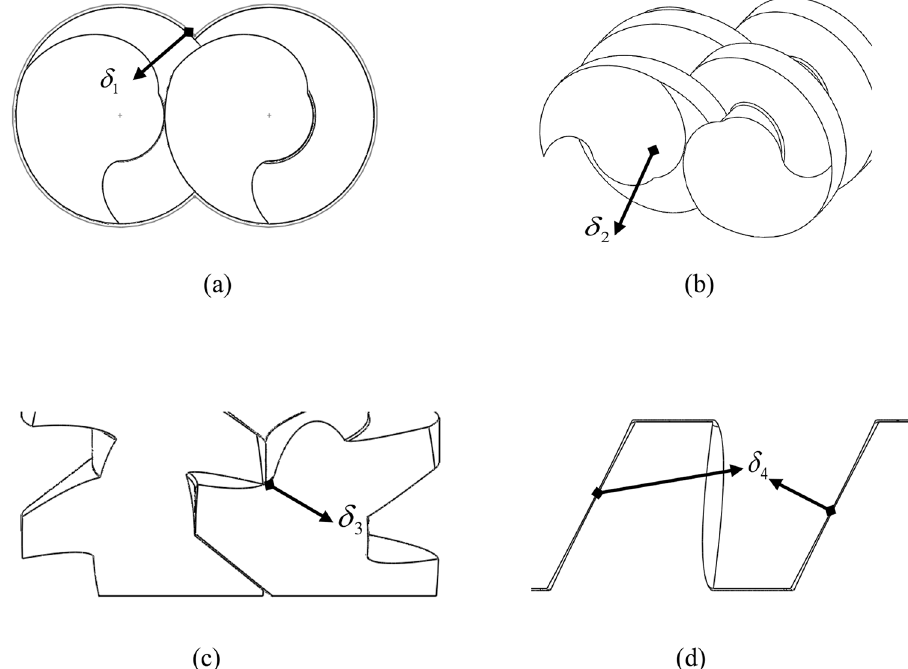
Fig. 5. Modi fi ed convex surface.